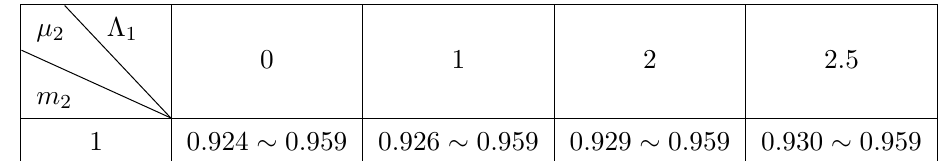
Table 1 . The domain of existence of the mass µ 2 of the scalar field φ 2 with various values of the